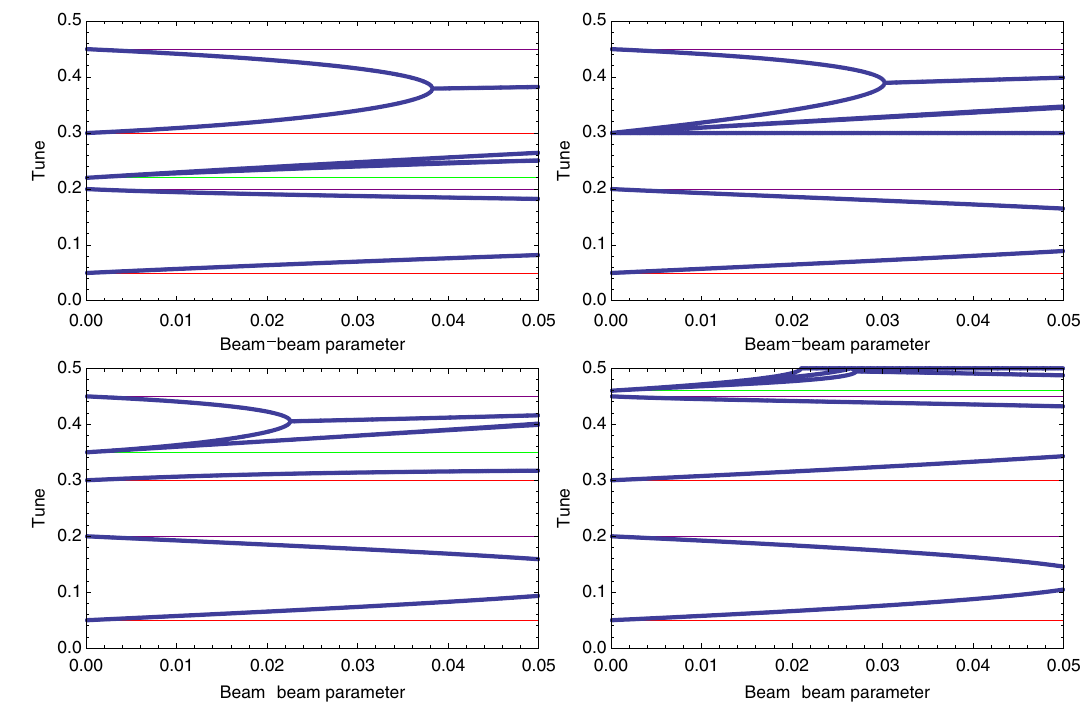
FIG. 1. The tunes extracted from matrix M T with different beam-beam parameters ξ . The vertical grid lines represent the tunes Ξ i when there is no beam-beam interaction. The green one denotes Ξ 1 and the red and purple ones represent the Ξ 2 or 1 − Ξ 2 in the range [0, 0.5], respectively. All figures have the number of bunches in two ring as ð N 1 ; N 2 Þ ¼ ð 3 ; 4 Þ with different tunes. The tunes are the following: top left ð ν 1 ; ν 2 Þ ¼ ð 0 . 22 ; 0 . 4 Þ ; top right ð ν 1 ; ν 2 Þ ¼ ð 0 . 3 ; 0 . 4 Þ ; bottom left ð ν 1 ; ν 2 Þ ¼ ð 0 . 35 ; 0 . 4 Þ and bottom right ð ν 1 ; ν 2 Þ ¼ ð 0 . 46 ; 0 . 4 Þ